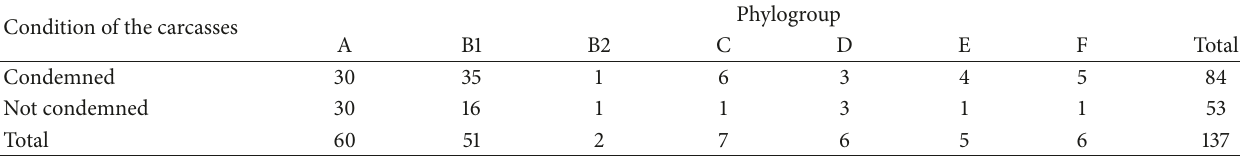
Table 2: Distribution of phylogroups of E. coli strains isolated from respiratory tract, liver, and heart of broilers condemned and not condemned during inspection.